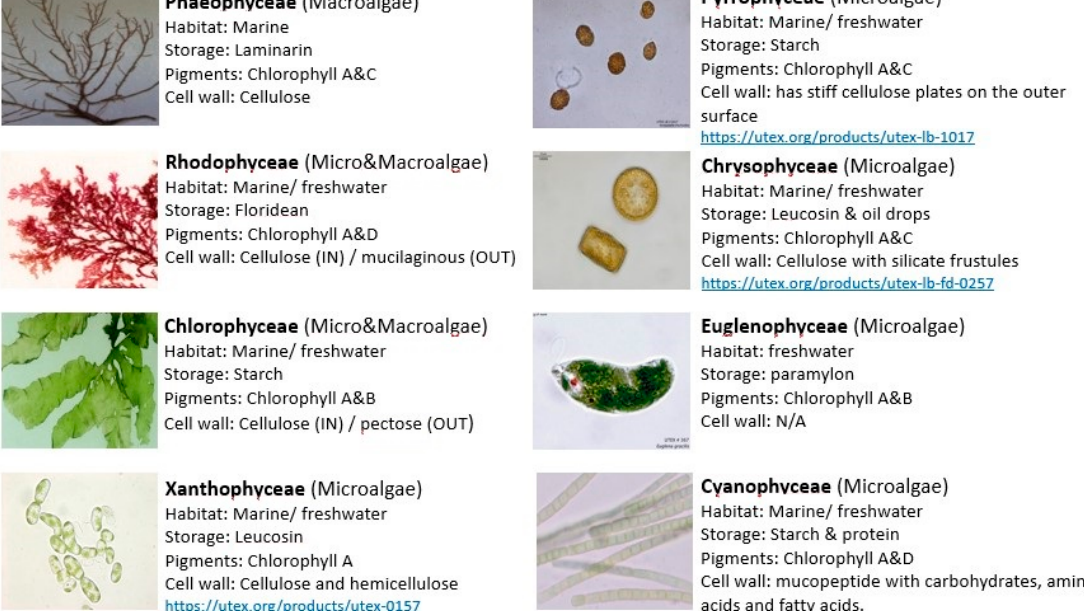
Figure 2. Different groups of algae. Various options are available for algae type and strain choice. They differ in shapes from a single cell to multicellular structures like filaments and colonies. Most algae can habit any imaginable environment and can withstand extreme conditions [16]. Algae are classified by their development to cyanoprokaryotes and eukaryotes. Cyanoprokaryotes are characterized by the lack of a well-defined nucleus and chloroplasts. Eukaryotic algae are further divided according to cell wall structure, pigments, and storage products into Chlorophyceae, Phaeophyceae, Rhodophyceae, Xanthophyceae, Pyrrophyceae, Euglenophyceae and Chrysophyceae. Unlike higher plants, algae have no embryo, vascular tissues or surrounding layer around sex organs. The economic importance of algae is evident in wastewater treatment, production of energy cogeneration, bioremediation, natural fertilizer, animal fodders, medicinal compounds and nutraceuticals. In addition, numerous products can be obtained from algae including proteins, vitamins, pigments, nutraceuticals and special oils (omega-3) [5]. Algae can use light more efficiently, grow faster and can produce 2–15 fold higher lipids than higher plants like Jatropha , rapeseed and soybean [17–20].